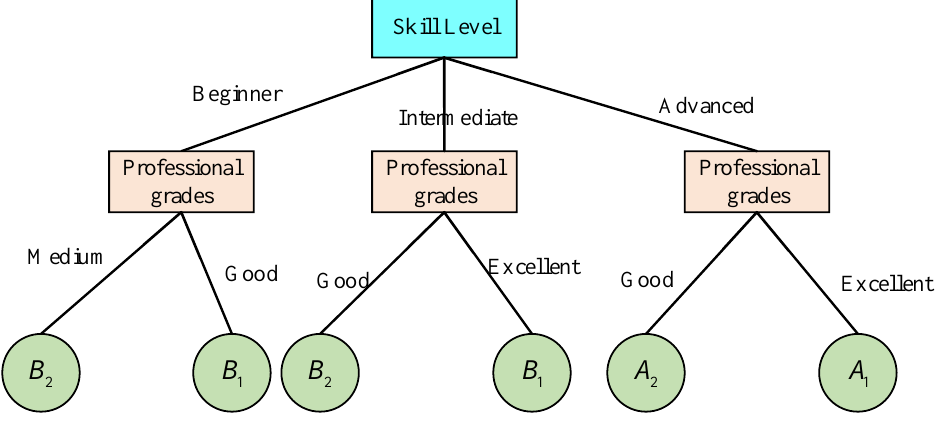
Figure 2. Decision tree generated at () f s = 0.8.